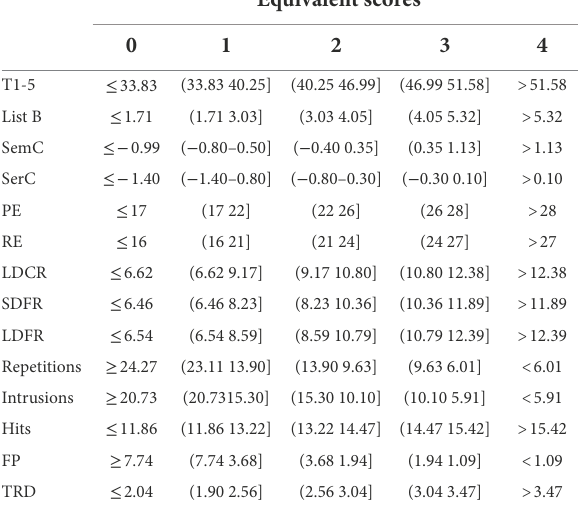
FIGURE 1 ROC curves of the CVLT-II factors (with significant group differences) for discrimination between persons with MS and healthy controls. The sensitivity/specificity of T1-5, SemC, SerC, SDCR, LDCR, SDFR, LDFR, repetitions and hits, respectively, are 62.1%/53.4, 69.0%/50.0, 51.7%/69.0, 51.7%/65.5, 55.2%/65.5, 51.7%/72.4, 65.5%/56.9, 55.2%/56.9, and 41.4%/77.6%, with area under the curve (AUC) values of 0.634, 0.658, 0.646, 0.663, 0.692, 0.660, 0.668, 0.660 and 0.669. ROC, receiver operating characteristic. T1-5, total learning in Trials 1–5, SemC, semantic clustering, SerC, serial clustering, SDCR, short-delay cued recall, LDCR, long-delay cued recall, SDFR, short-delay free recall, LDFR, long-delay free recall.